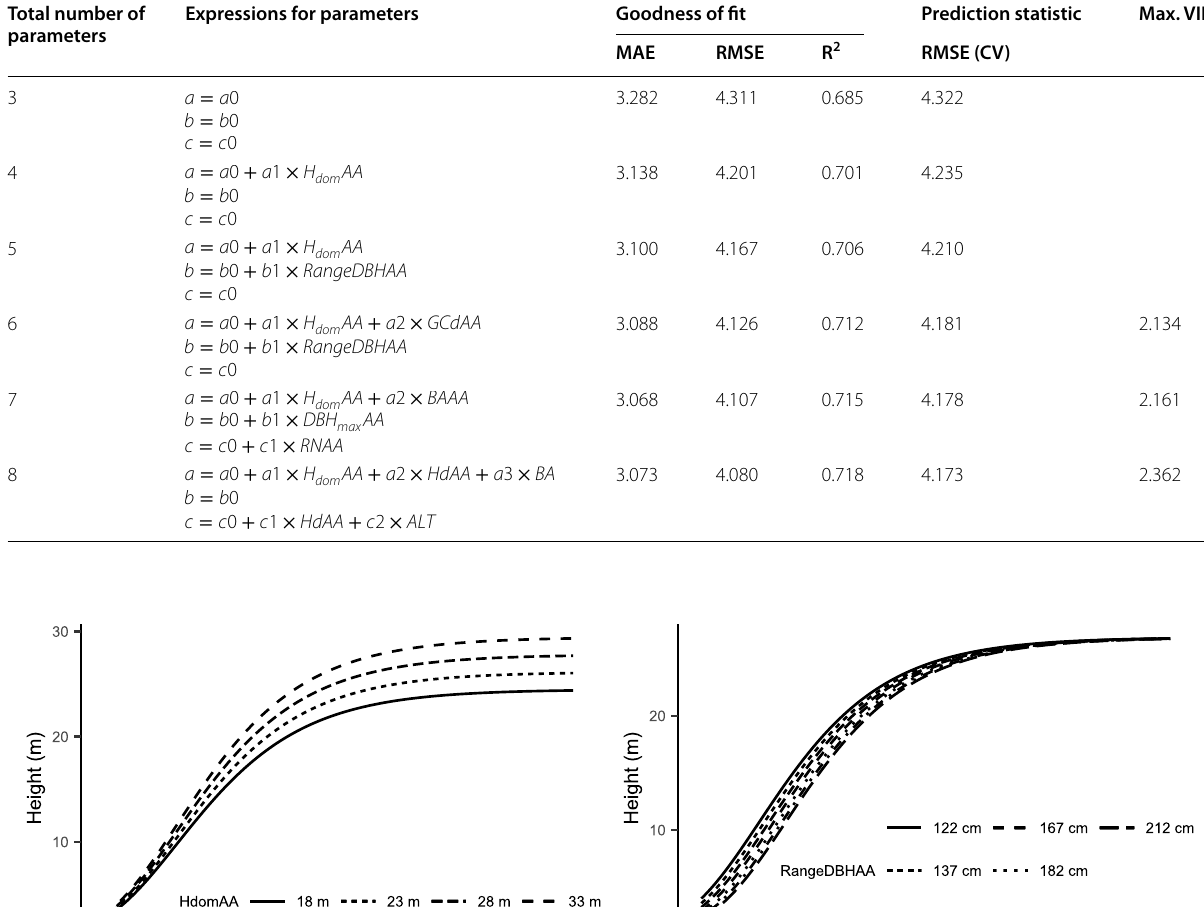
Table 4 Results from the inclusion of stand variables for SM12 AA